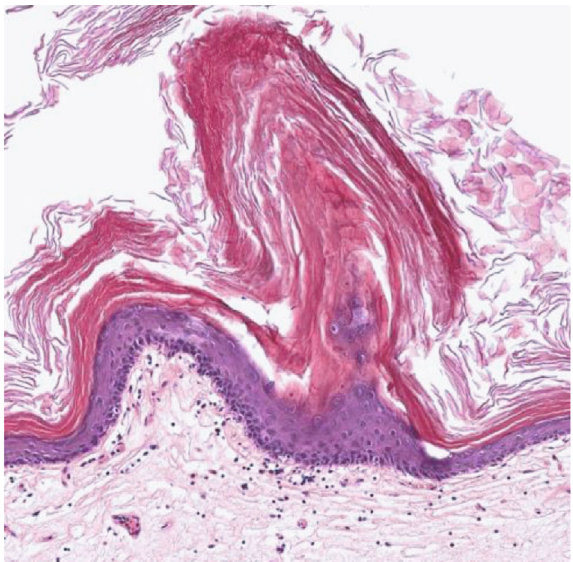
Figure 5: Hyperkeratotic, acanthotic squamous epithelium lining the lumen of the bladder with papillomatosis.